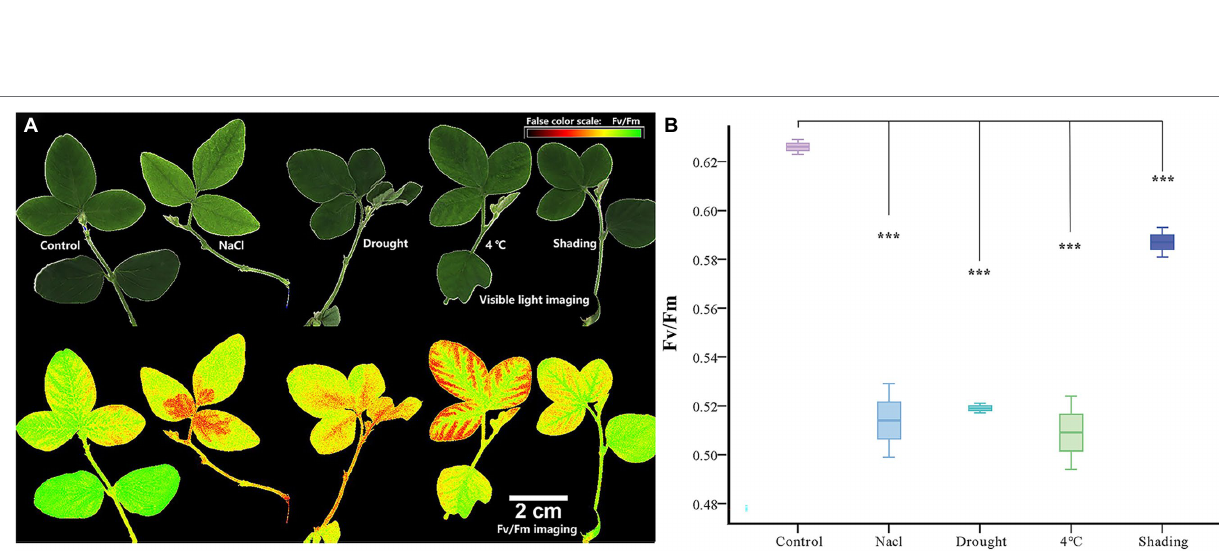
FIGURE 5 | Chlorophyll fluorescence imaging and chlorophyll fluorescence yield ( F v / F m ) index in vegetable soybean under control and abiotic stress. (A) Abiotic stress damage in soybean leaves is visualized by chlorophyll fluorescence imaging. The panels show false-color images of the chlorophyll fluorescence yield ( F v / F m ) of leaves after 12 h stress. (B) Quantitative comparison of abiotic stress damage to soybean leaves determined by chlorophyll fluorescence imaging ( F v / F m ). *** p ≤ 0.001.